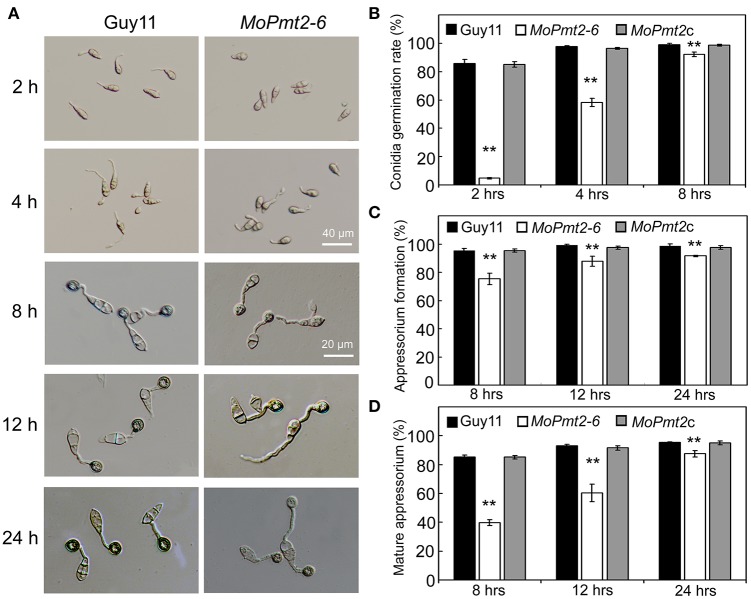
Conidial germination and appressorium formation. (A) Delayed conidial germination and appressorium formation of the MoPmt2 mutant. Conidia of indicated strains were harvested from 14-day-old cultures. Droplets of conidial suspension (1 × 105 ml−1) were inoculated on the hydrophobic surface of the coverslips for indicated time, and then photographed. Scale bars are indicated in the figure. (B) Statistical analysis of conidial germination. Germinated conidia were counted at each indicated time under a light microscope, and statistically analyzed by Duncan analysis. (C) Statistical analysis of appressorium formation. Appressorium formed at the germ tube were counted and statistically analyzed. (D) Measurement of mature appressorium. Appressorium formed at the germ tube with melanin were counted, and the ratio of mature appressorium was statistically analyzed. Asterisks in this figure indicate significant differences from the control (p < 0.01). Error bar represents standard deviation.